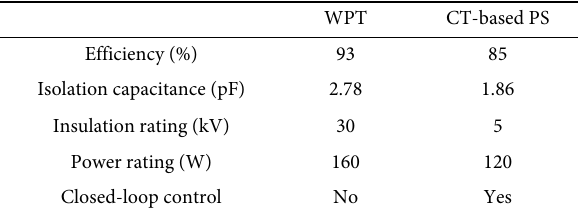
Table 2 Performance of WPT and CT-based PS